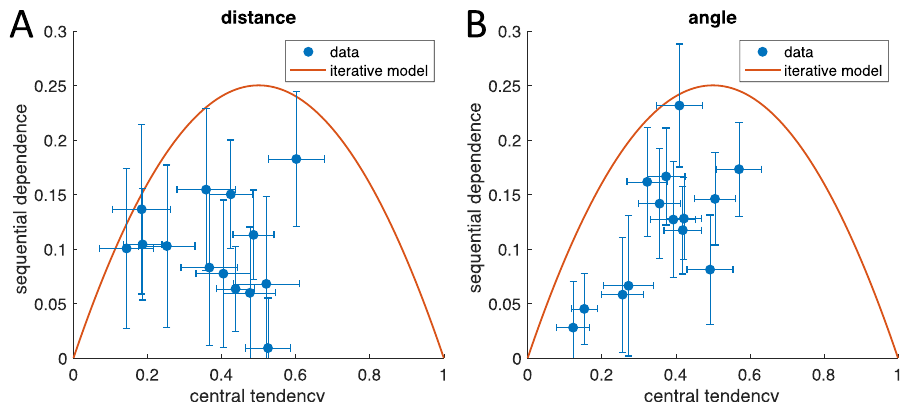
Figure 3. Sequential dependence for distance ( A ) and angular ( B ) reproduction plotted over central tendency for all subjects. Distance and angular reproduction data come from 9 , data published as 19 , each point corresponds to 540 trials. Error bars denote standard error of the mean. The same analysis was applied as in Fig.